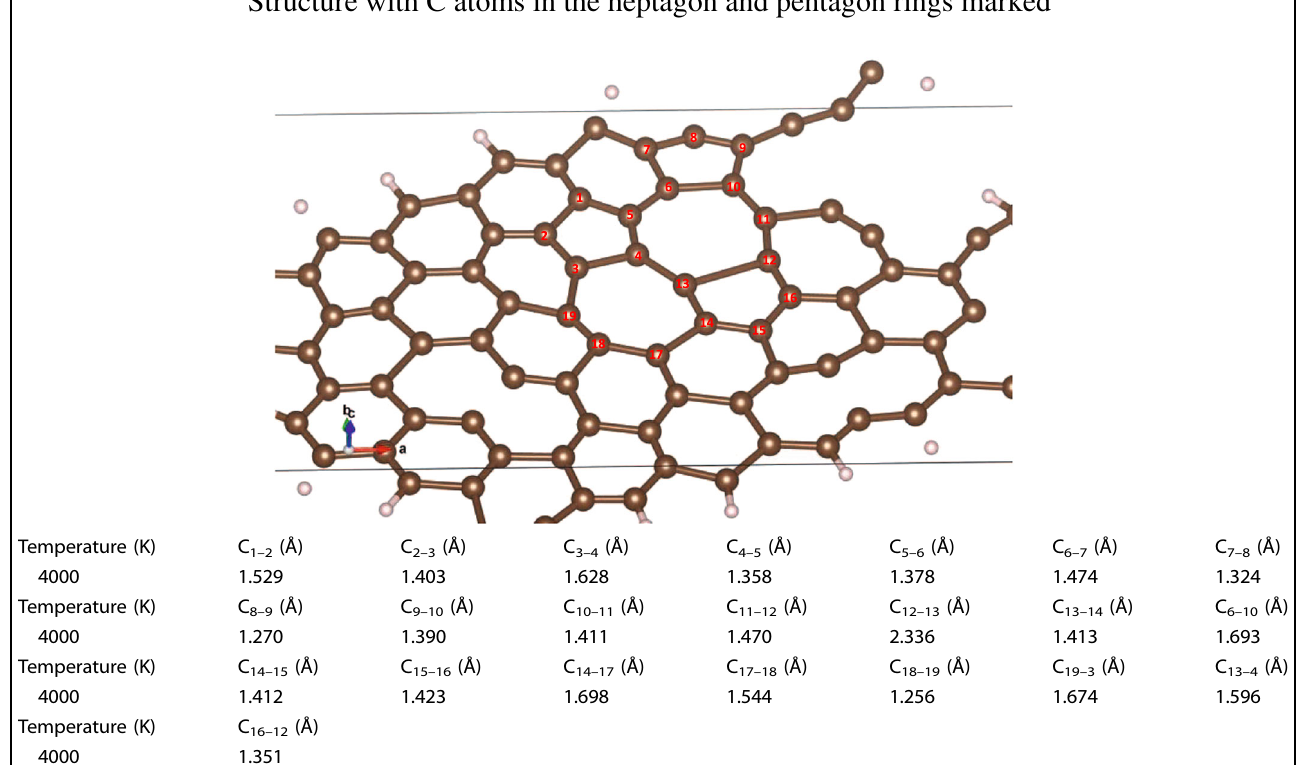
Structure with C atoms in the heptagon and pentagon rings